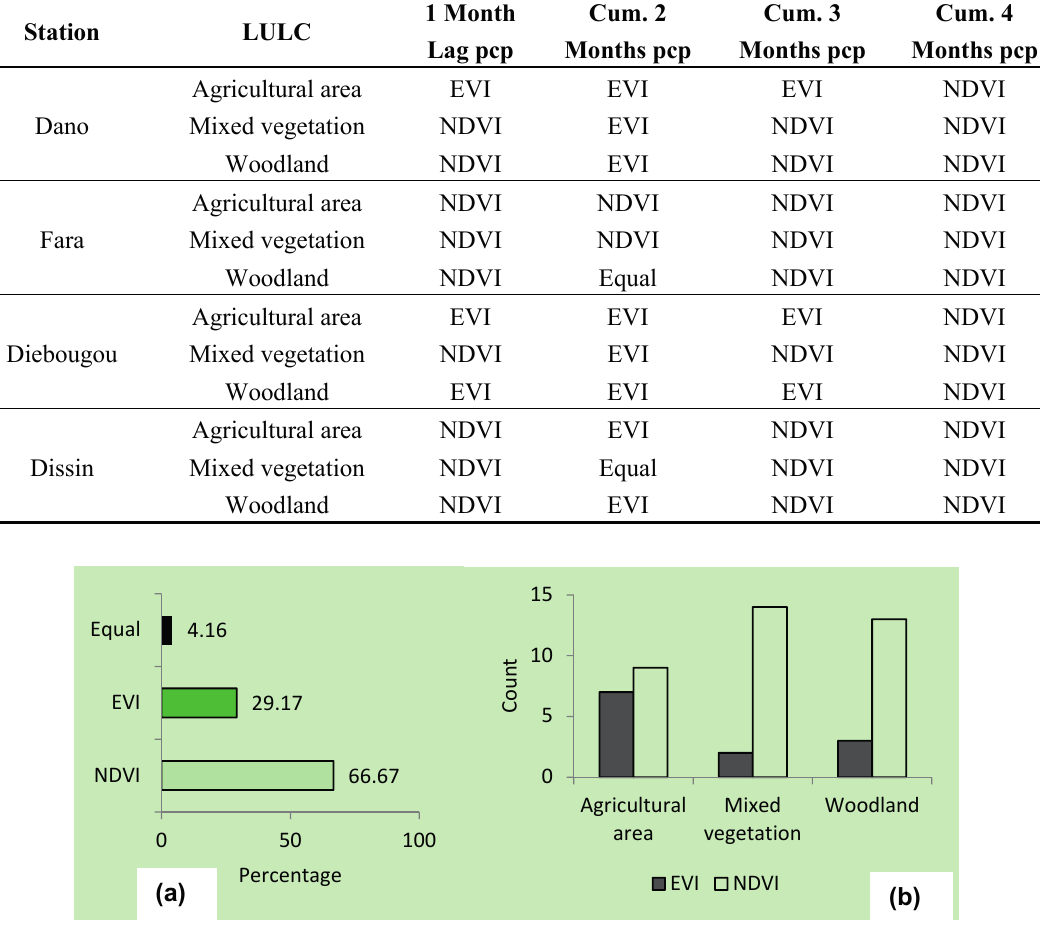
Figure 4. ( a ) Global best performance between NDVI and EVI; ( b ) NDVI and EVI performance according to land